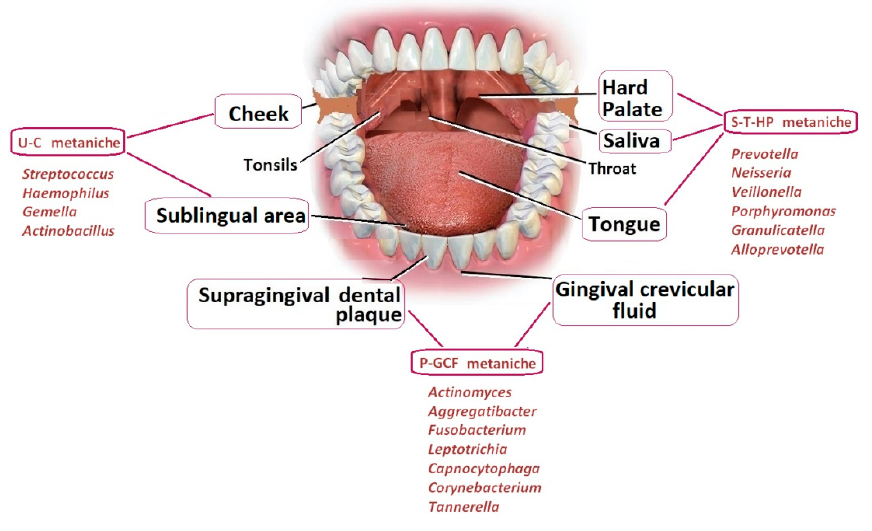
Figure 3. The types of biological samples that have been collected during the Human Microbiome Project population: saliva, palate, tonsils, throat, buccal mucosa (cheek), tongue soft tissues, supragingival dental plaque, etc. (adapted after [15,27]; metaniches and the composition of the oral microbiota associated with anatomically diverse oral regions: U-C metaniche: sublingual-cheek region, P-GCF metaniche: supragingival dental plaque—gingival crevicular fluid region, S-T-HP metaniche: saliva–tongue–hard palate region [28].